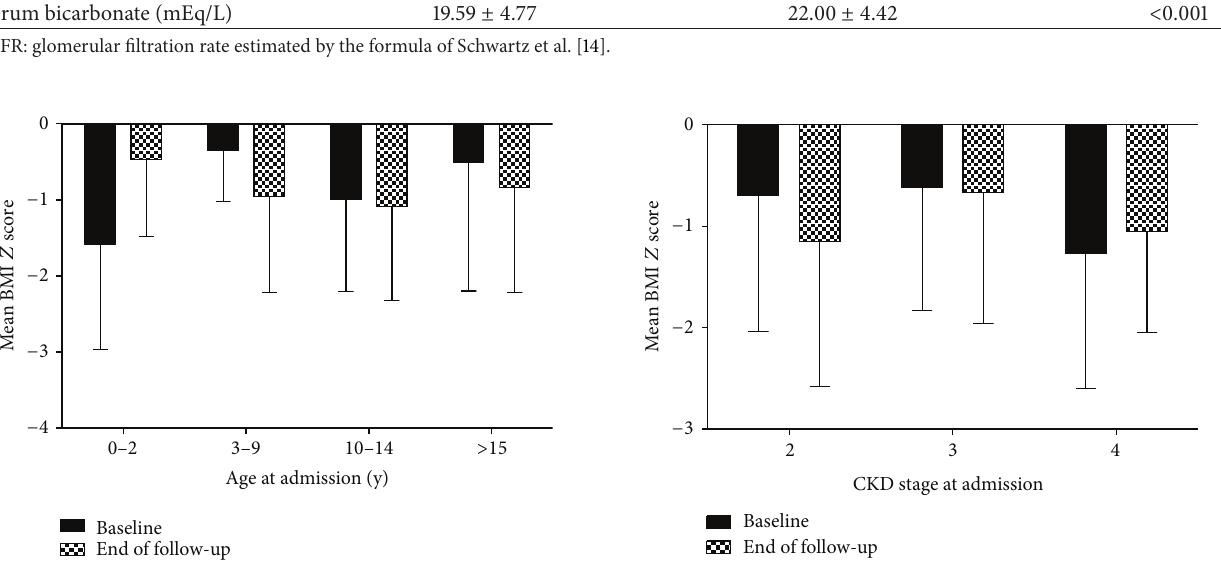
Figure 2: Mean values of body mass index (BMI) 𝑍 score at admission (baseline) and at last follow-up visit (end of follow-up) according to age at admission (expressed in years) for pediatric patients with chronic kidney disease.